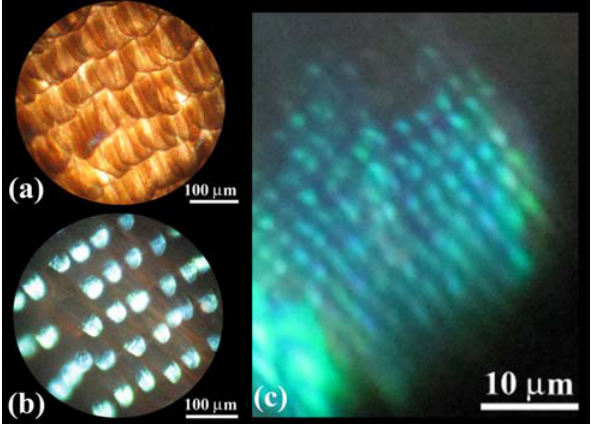
Figure 7. OM images of the dorsal wing scales of the male C. ataxus taken by white light. ( a ) Transmission image; ( b ) Reflection image; ( c ) Enlarged image of a scale in (b) (adapted from